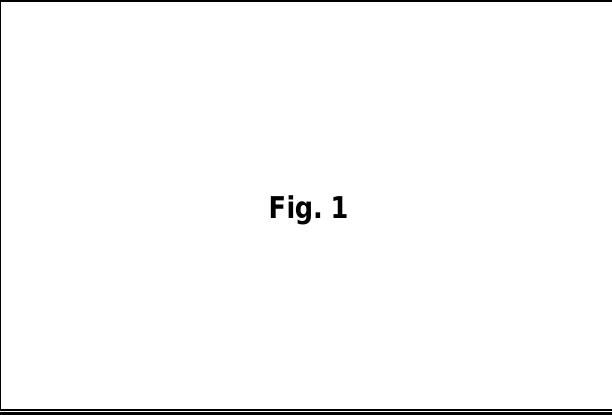
Fig.1 : Left common iliac occlusion and right common iliac stenosis.